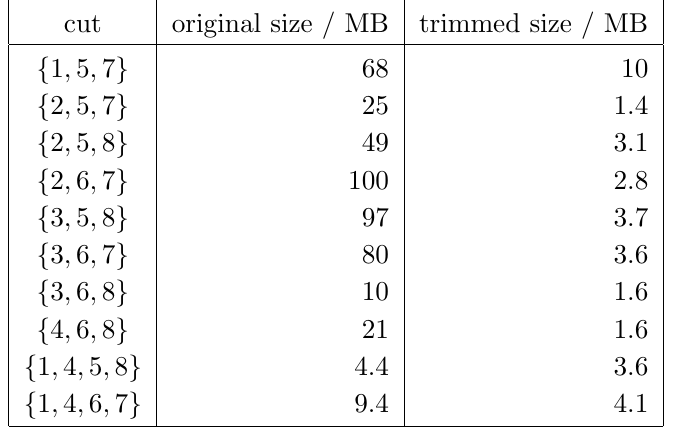
Table 3 . String sizes of the original and trimmed generating systems, given in